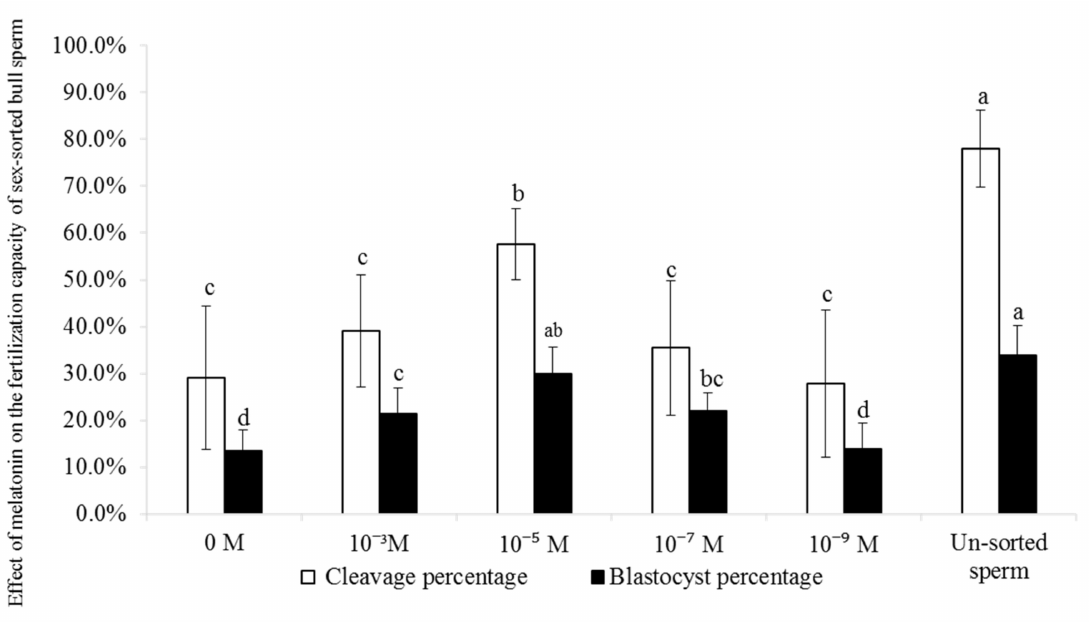
Figure 9. E ff ect of melatonin on the IVF e ffi ciency of sex-sorted bull sperm. Lowercase letters represent statistical significant di ff erence ( p <